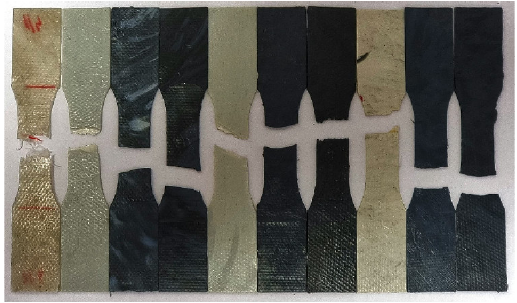
Figure 7. Test samples in order as in Table 6 after tensile testing .